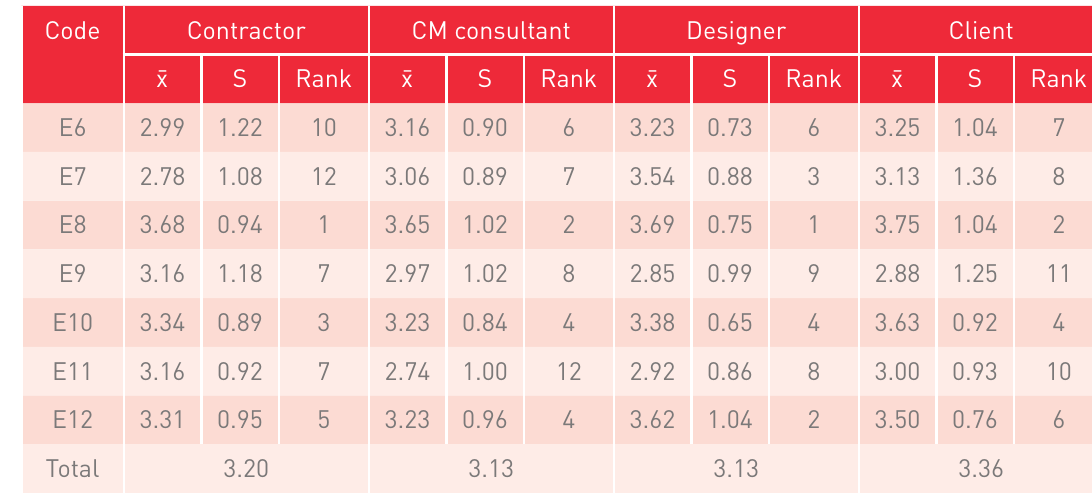
Table 13. Tukey Post-hoc Test for the level of barriers among construction practitioners Code Practitioners Mean difference Sig. Drone technology is changing Contractor Design Consultant .79186* 0.024 rapidly RELATIONSHIPS BETWEEN DRONE READINESS DIMENSIONS